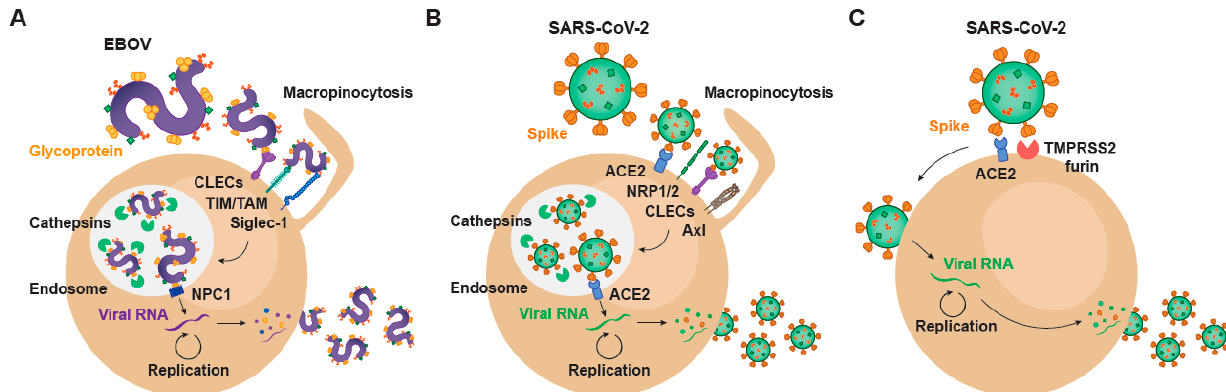
Figure 1. Viral and host factors involved in EBOV and SARS-CoV-2 infectious cycle. ( A ) EBOV entry into target cells is mediated by macropinocytosis, which directs surface-attached viral particles to the endosomal trafficking pathway. Within endosomes, host cathepsins cleave viral glycoprotein, facilitating interaction with the NPC1 receptor and viral membrane fusion. In the cytoplasm, the viral RNA genome undergoes transcription/replication, resulting in the synthesis of new viral particles that exit infected cells through membrane budding. ( B ) SARS-CoV-2 can enter target cells through an endosomal pathway that parallels EBOV internalization. Within endosomal compartments, cleavage of the Spike protein results in viral fusion and cytoplasmic entry, where viral replication occurs. ( C ) SARS-CoV-2 also enters target cells through an alternative mechanism in which Spike protein is cleaved at the cell surface, a process mediated by proteases such as TMPRSS2 and furin. In this case, the viral genome gains access to the cytoplasm through viral fusion with the plasma membrane. EBOV: Ebola virus; CLECs: C-type lectin receptors; TIM: T-cell immunoglobulin and mucin receptors; TAM: Tyro3-Axl-Mer receptors; Siglec-1: sialic acid-binding Ig-like lectin 1; NPC1: Niemann-Pick receptor C1; SARS-CoV-2: severe acute respiratory syndrome coronavirus 2; ACE2: angiotensin-converting enzyme 2; NRP1/2: neuropilin 1/2; TMPRSS2: transmembrane protease serine